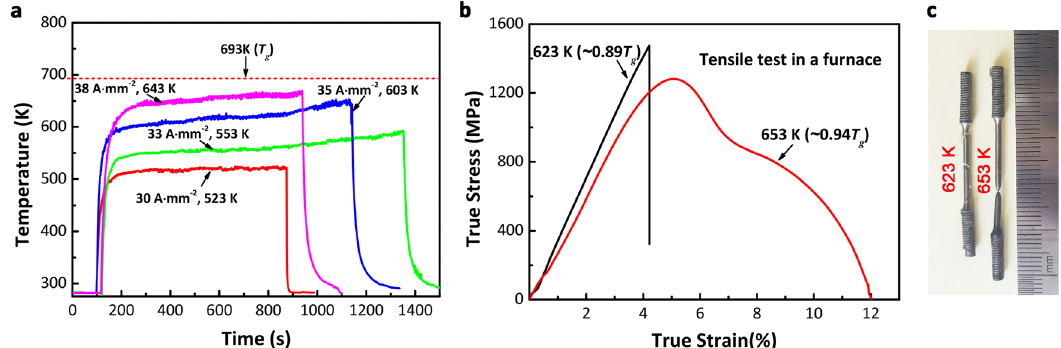
Fig. 3 Evaluation of the Joule heating effect. a Real-time temperature pro fi les of Zr 55 Cu 30 Al 10 Ni 5 (Zr55) bulk metallic glass (BMG) specimens during tensile tests under pulsed currents of different current density, con fi rming that the specimen temperatures are below the glass transition temperature T g ; b true stress – strain (SS) curves of Zr55 BMG in tension at elevated temperatures in a furnace under no pulsed current; c morphologies of Zr55 BMG specimens after tensile tests at elevated temperatures in a furnace. The specimen tested at 623 K exhibits a brittle fracture via shear banding, in contrast to the elongation and necking of the BMG specimen tested under a pulsed current of a density i = 33 A·mm − 2 , of which the specimen temperature is 553 K, even 70 K lower, indicating that the homogeneous deformation of Zr55 BMG under pulsed current is not due to the temperature rise caused by Joule heating effect. The specimen tested at 653 K exhibits